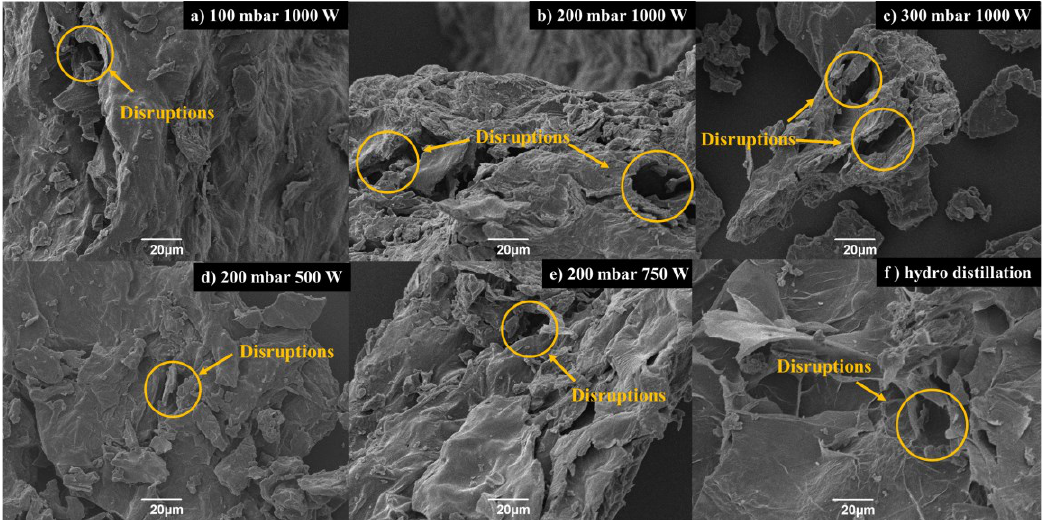
Figure 6. Morphological features of cucumber residues (scale bar = 20 µ m) produced using various experimental conditions during VMHD (pressure, power): ( a ) 100 mbar 1000 W, ( b ) 200 m 1000 W, ( c ) 300 m 1000 W; ( d ) 200 mbar 500 W, ( e ) 200 mbar 750 W, and ( f ) hydro-distillation. The disruptions are highlighted in red